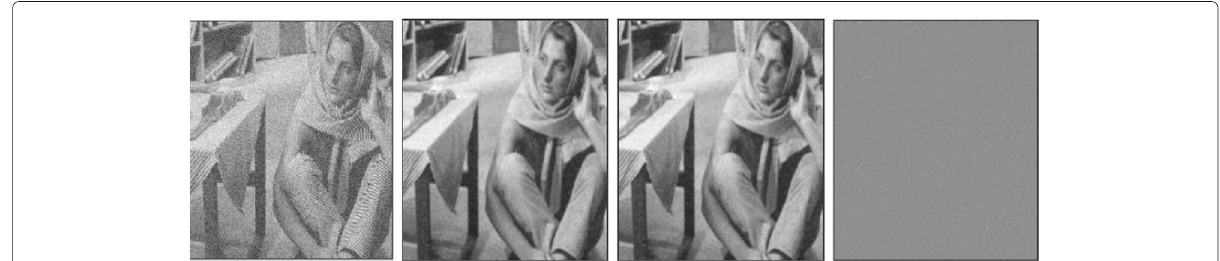
Fig. 7 Lefttoright: noisy image, restored Barbara image by our method, image obtained by PMPL model with p = 20, the difference image